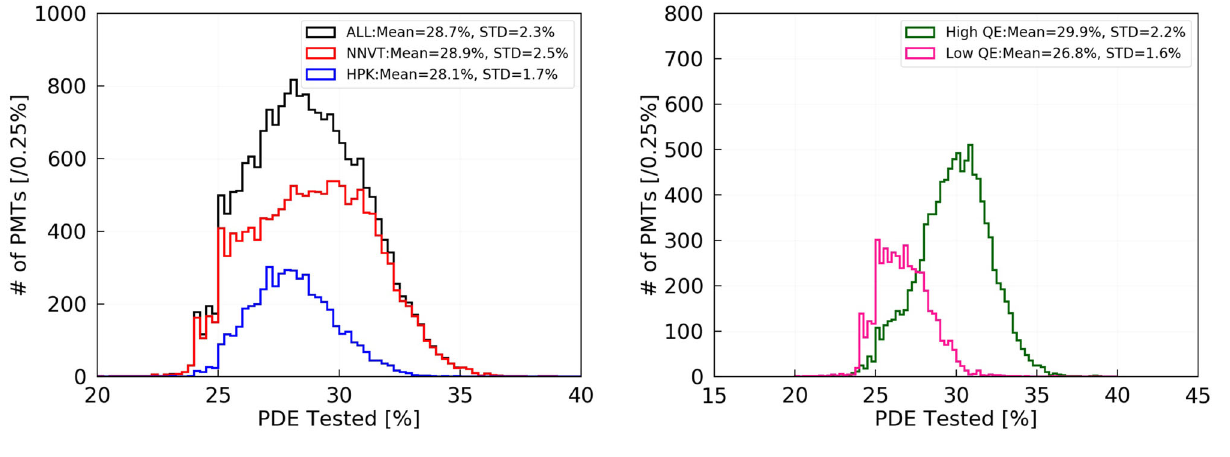
Fig. 17 Measured PDE distribution of all qualified PMTs (left), and of all qualified NNVT PMTs (right). Black: all PMTs; red: NNVT; blue: HPK; Right: dark green: High_QE; deeppink: